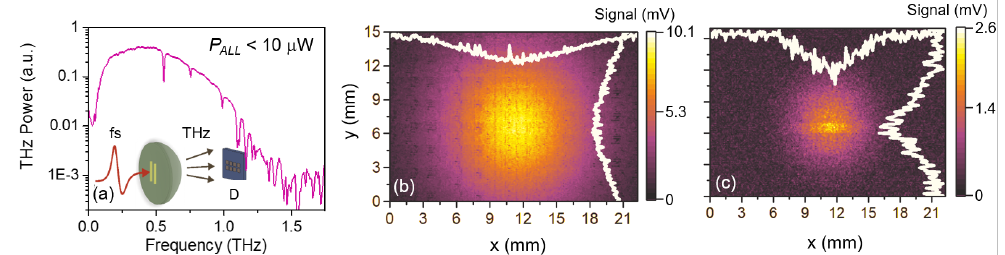
Figure 5. Spectrum of THz pulsed emitter (antenna switch) plotted in semi log scale ( a ). The measurement geometry is shown in the inset, where fs denotes to optical femtosecond pulse exciting THz emission from LTG GaAs optoelectronic switch, D labels Ti-mB detector. Note sharp lines caused by water vapour absorption in the air decorating the THz emission spectrum. Beam profiles of THz pulsed emitter obtained with antenna-coupled Ti-mB optimized for resonant frequencies of 0.3 THz ( b ) and 0.7 THz ( c ). White lines indicate intensity cross sections along the relevant